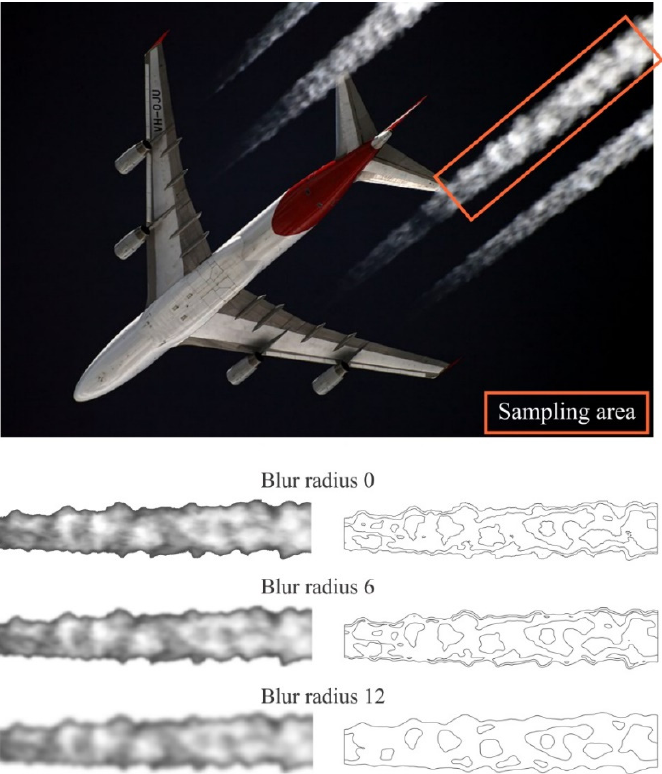
Figure 5. Images of Boeing trace contour maps for different blur factors. Contour intervals on the relative scales [0,1] are 0.6 and 0.8.